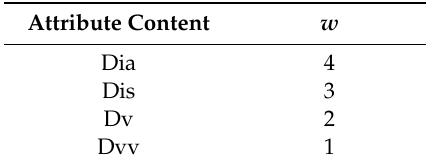
Table 2. Data unit value ( duv ) for simple data, corresponding to the weight w (which is related to its content). Dia: indispensable data for authorization; Dis: indispensable data for the system; Dv: simple verification data; Dvv: Doble verification